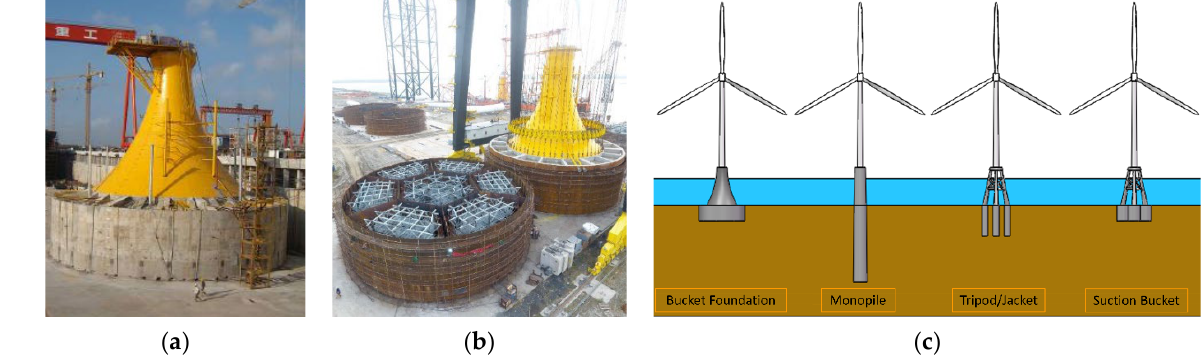
Figure 1. Construction of a bucket foundation and different foundations: ( a ) thick-walled; ( b ) thin-walled; ( c ) types of offshore wind foundations.